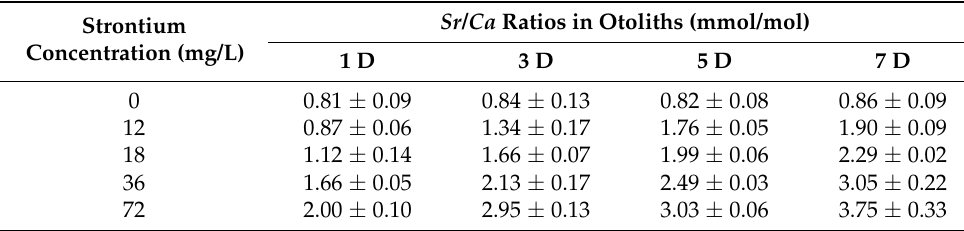
Table 2. The change of Sr / Ca ratio in the otoliths of T. obscurus in different